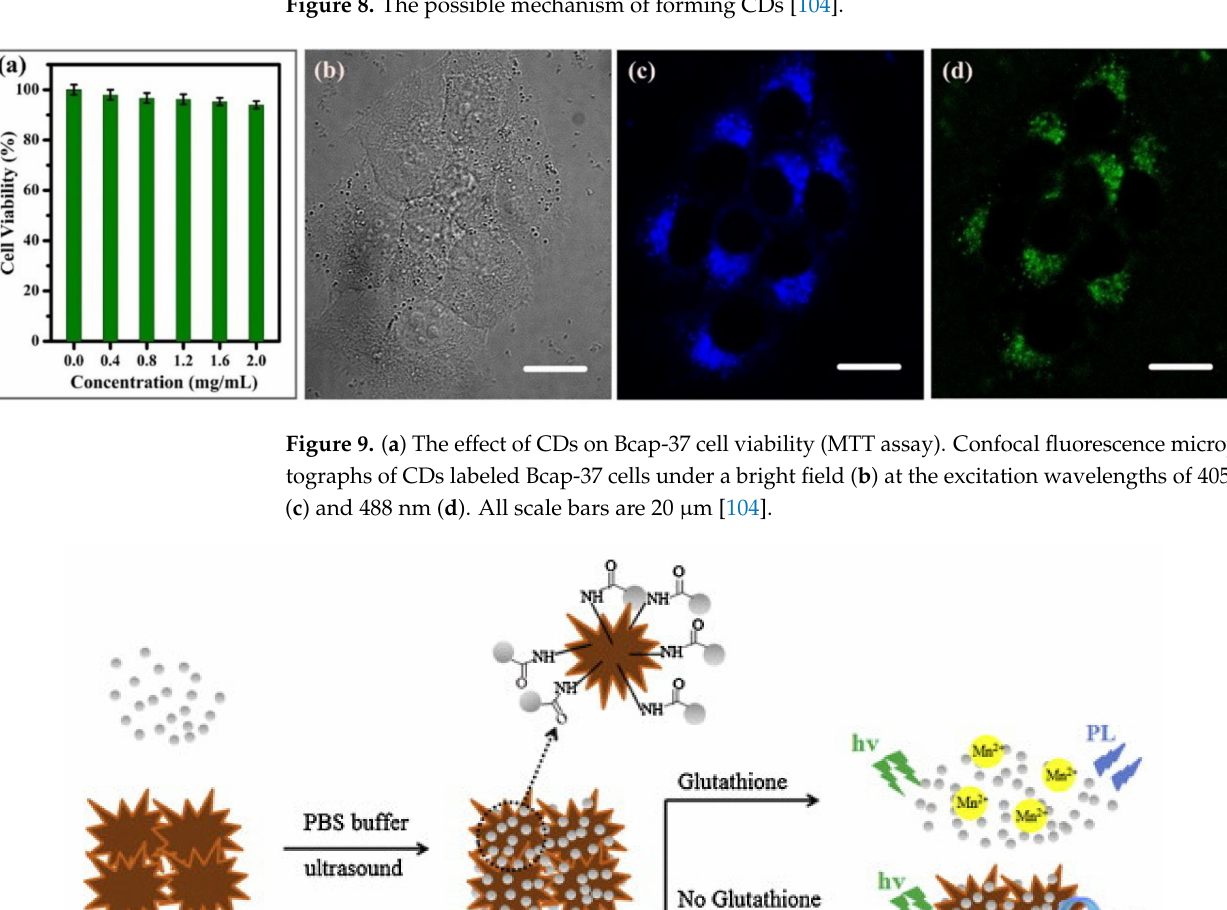
Figure 8. The possible mechanism of forming CDs [104].